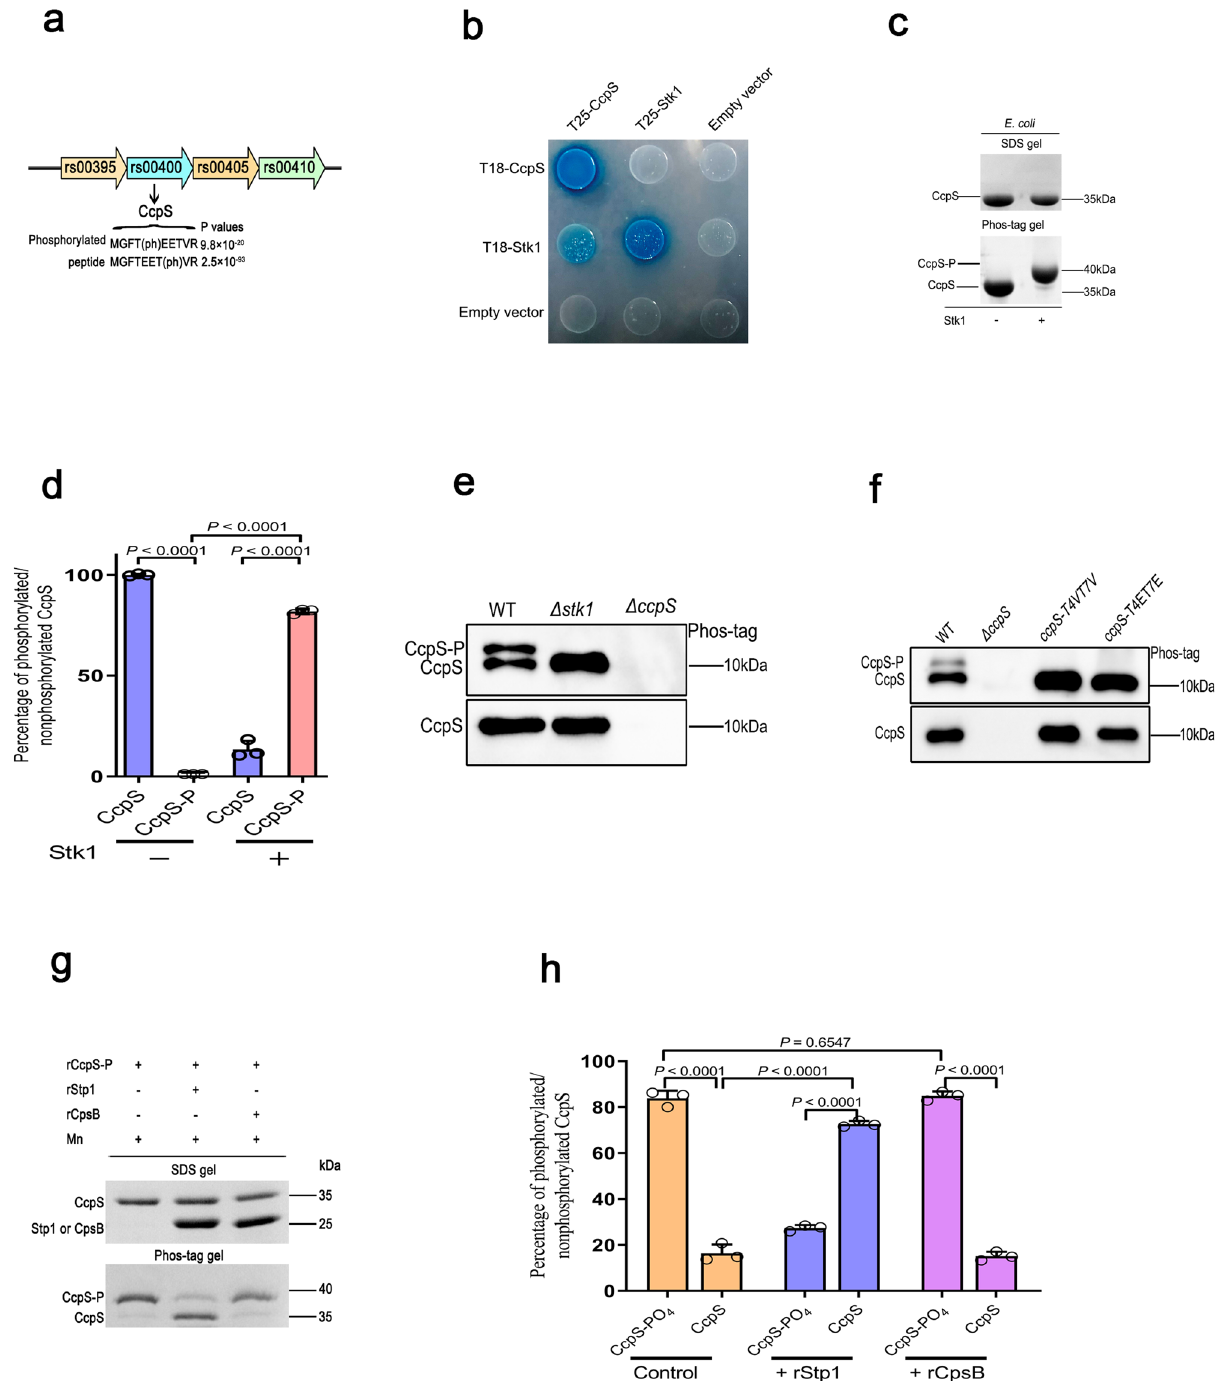
Fig. 1 | The CcpS phosphorylation is modulated by the Stk1/Stp1 system. a The schematic shows the genetic context of rs00400 ( ccpS ) and the phosphorylation possibility of detected phosphorylated CcpS peptides, which was calculated by Maxquant (version No. 1.5.2.17), n =3 independent biological replicates. b The interactionbetweenStk1andCcpSwasveri fi edbyabacterialtwo-hybridassay.Blue colony formation suggests that a direct interaction occurs. c CcpS-GST was expressedintheabsenceorpresenceofectopicexpressionofStk1inheterologous host E. coli cells, GST agarose beads were used to pull down CcpS-GST, and the samples were loaded onto Phos-tag gel to analyze the phosphorylation of CcpS, samples also were loaded onto a standard SDS gel as a loading control and Coo- massie stain. d Bar graph shows the percentage of phosphorylated and non- phosphorylated CcpS in E. coli cells in the absence or presence of ectopic expres- sion of Stk1 (density analysis for c ). Data represent mean±SD from n =3 biologi- callyindependentexperiments. e , f IPanalysisofCcpSphosphorylationin S.suis in